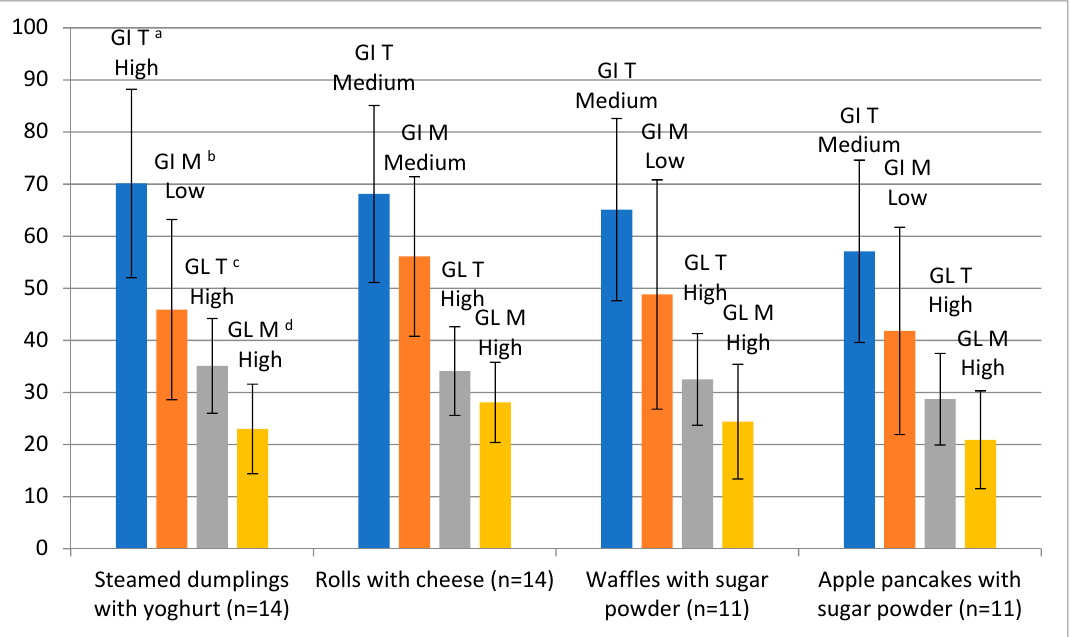
Figure 1. Glycaemic index (GI) and glycaemic load (GL) of the examined dishes. GI T / GL T—Glycaemic Index and Glycaemic Load of the traditional version; GI M / GL M—Glycaemic Index and Glycaemic Load of the modified version; a,b,c,d statistically significant differences determined by the Student’s t -test at p < 0.05 ( a,b GI, c,d GL). GI values were classified as high ( ≥ 70), medium (56–69) and low ( ≤ 55) [27]; GL values were classified as high ( ≥ 20), medium (11–19) and low ( ≤ 10) [18].